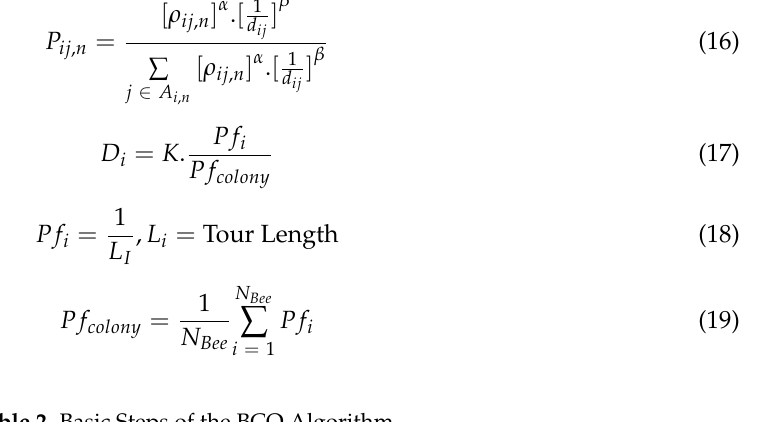
Table 2. Basic Steps of the BCO